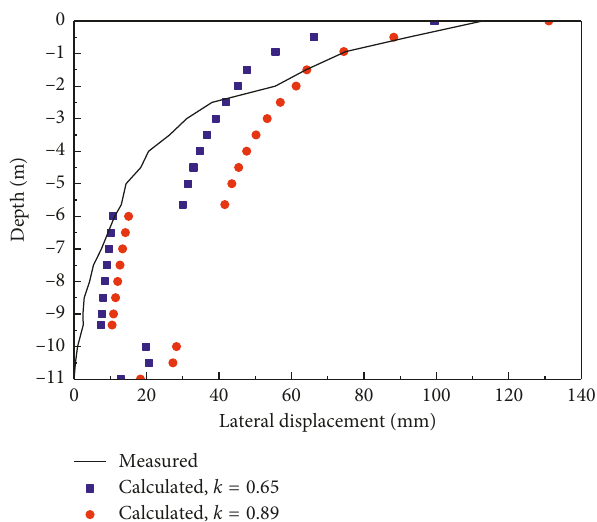
Figure 11: Lateral displacement at a distance of 20m from Section 2